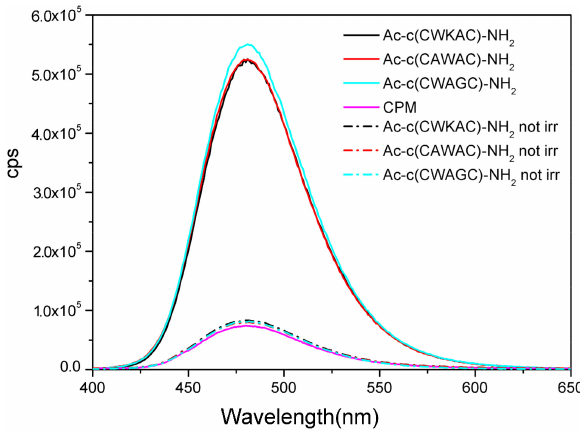
Figure 8. Detection of free sulfhydryls by fluorescence emission spectroscopy: CPM–peptide adducts after 1h illumination of the peptides at 280 nm ( λ ex = 387 nm). CPM was added to the not illuminated samples for control (dash